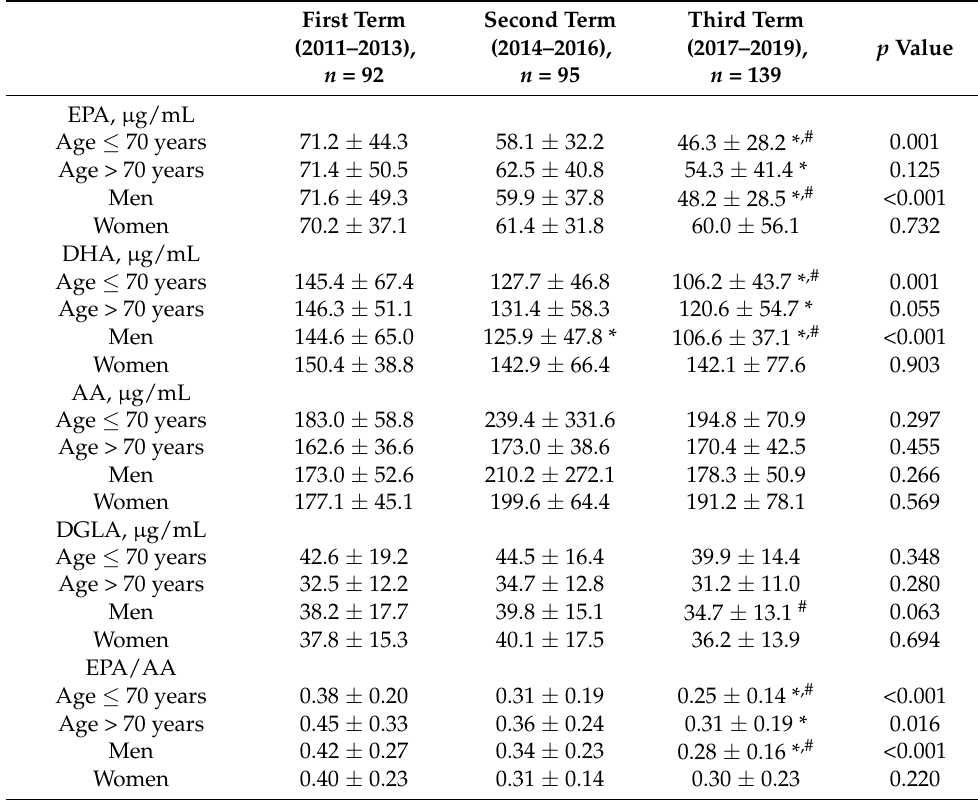
Table 3. Secular trend in polyunsaturated fatty acids in patients with diabetes.